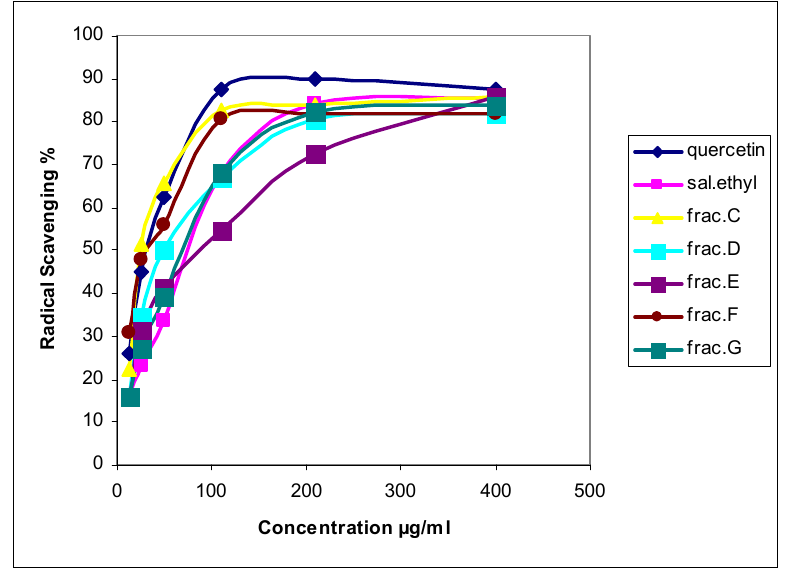
Figure 2 . Radical scavenging activity of Salvia mirzayanii and sub-fractions compared with quercetin as a standard.